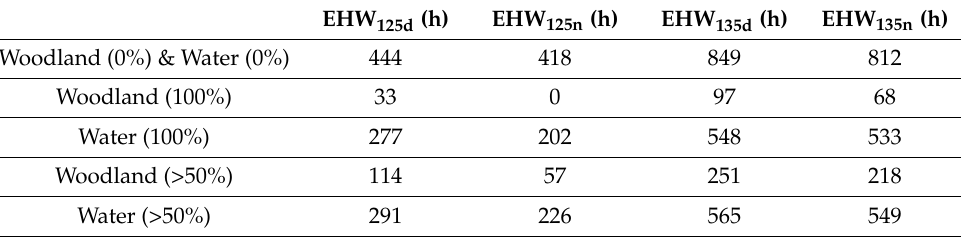
Table 2. Average values of EHW 125d , EHW 125n , EHW 135d , and EHW 135n under different proportions of woodland and water area. EHW 125d (h) EHW 125n (h) EHW 135d (h) EHW 135n